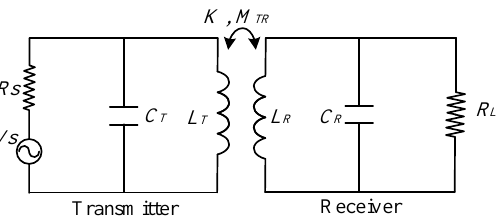
Figure 2. Equivalent circuit of the wireless power transfer system.